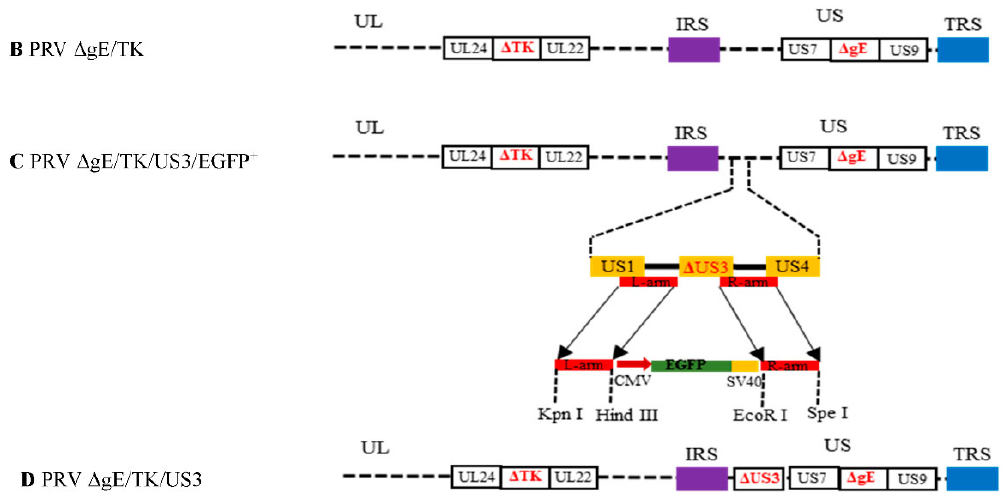
Figure 1. Schematic diagrams of PRV ∆ gE/TK/US3. ( A ) pSK-US3-LR-EGFP recombinant plasmid. ( B )The schematic representation of PRV ∆ gE/TK genome in which partial coding regions of gE and TK genes are deleted. ( C ) The schematic representation of PRV ∆ gE/TK/US3/EGFP + genome in which partial coding regions of gE, TK and US3 genes are deleted and an EGFP expression cassette is inserted into the US3 deleted locus. ( D ) The schematic representation of PRV ∆ gE/TK/US3 genome. PRV ∆ gE/TK strain genome DNA and pSK-US3-LR-EGFP plasmid were co-transfected into 293T cells using Lipofectamine ® 2000 transfection reagent (Invitrogen). When there Table 1. Primers that were used in this study. was a significant amount of cytopathic effect (CPE) to collect the transfection mixture, and the patches with green fluorescence were selected under fluorescence microscopy.